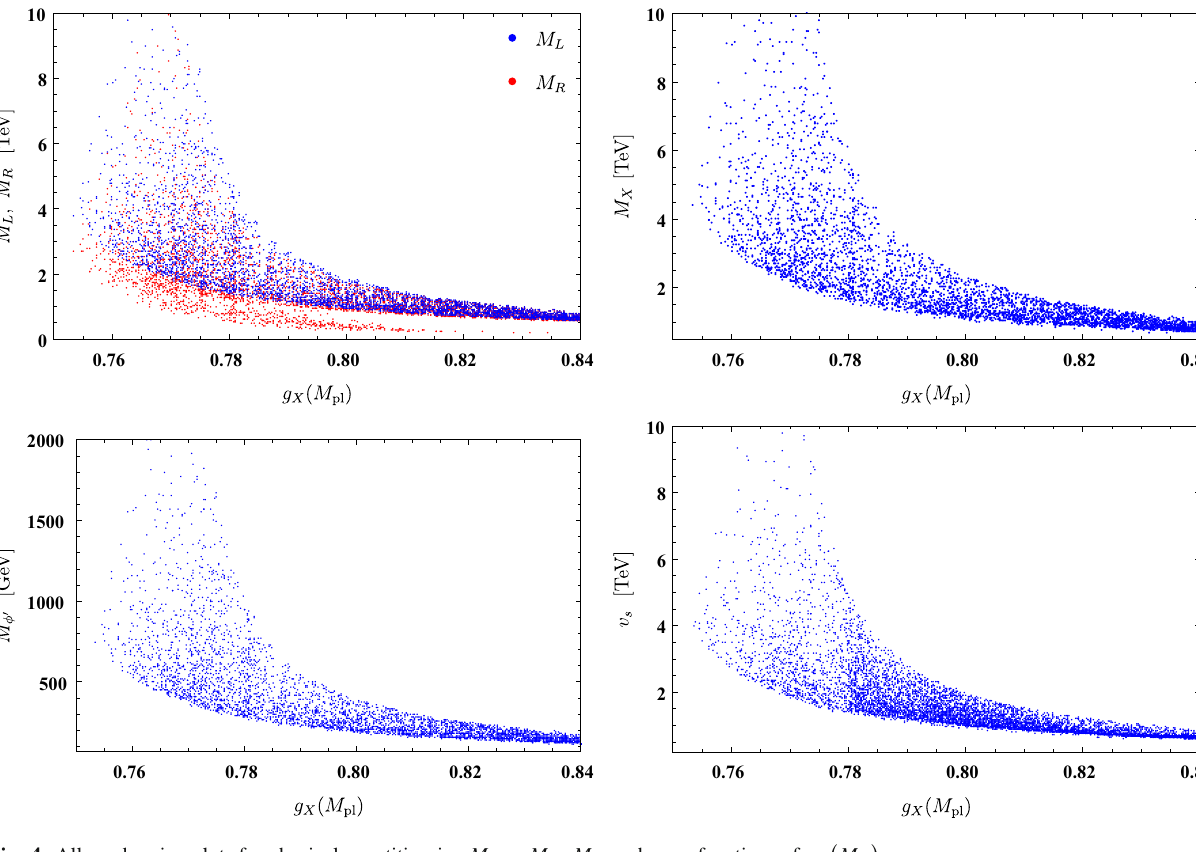
Fig. 4 Allowed region plots for physical quantities, i.e. M L , R , M X , M φ (cid:9) and v S as functions of g X